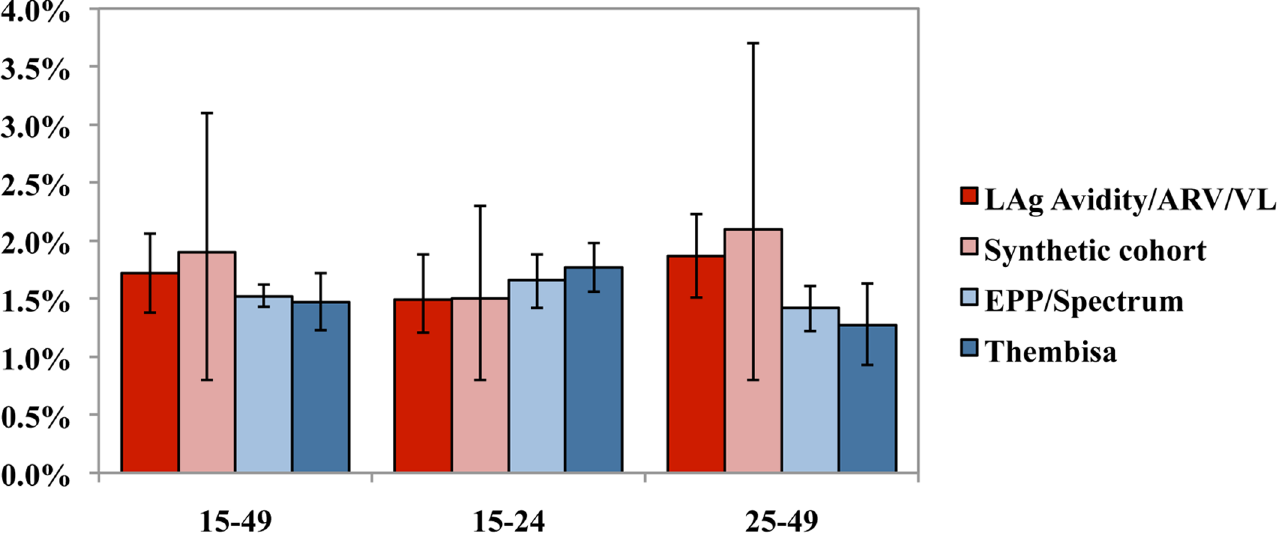
Fig 3. HIV incidence by age group and estimation method, South Africa 2012. 2012 HIV incidence rates (males and females combined) for the age groups 15 – 49 years, 15 – 24 years and 25 – 49 years provided by the four different estimation methods (LAg-Avidity/ARV/VL, Synthetic cohort, EPP/Spectrum, Thembisa). The error bars show the 95% uncertainty interval.